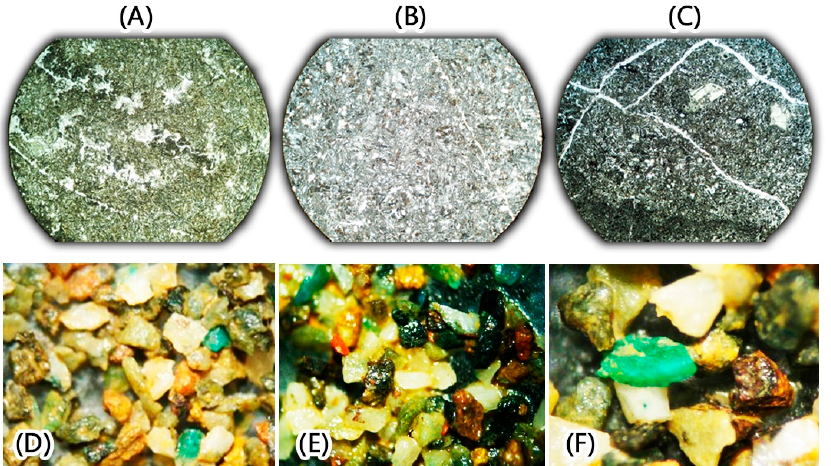
Figure 24. Petrological sections (4x magnification with natural light-A) and washed stream sediment samples (Binocular study (20×)). ( A ) Andesite-basalt, has plagioclase microlites that were com- pletely replaced by argillaceous materials and clay minerals; ( B ) Basalt, contains clinopyroxene and plagioclase needles; ( C ) Andesite-basalt, containing plagioclase microlites from albite to oligoclase; ( D ) Malachite and a tiny amount of chalcopyrite; ( E ) Magnetite, quartz, calcite, limonite and olivine; ( F ) Malachite, quartz and limonite.